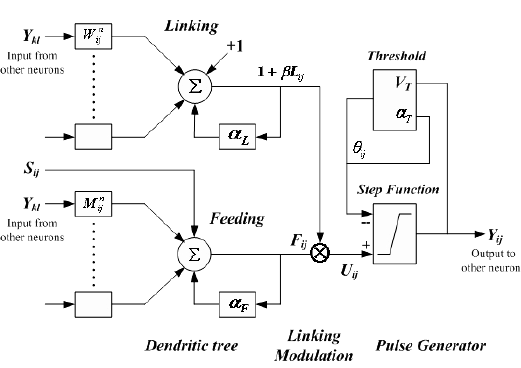
Figure 1. Structure of a PCNN